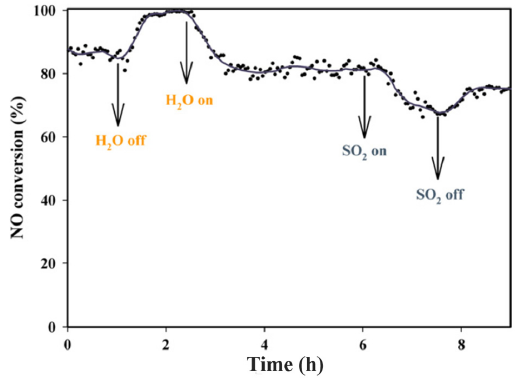
Figure 24. The effects of the H 2 O and SO 2 in the Mn/Ce(4)–TiO 2 catalysts with different ratio of Ce/Ti (Reaction condition: 200 ppm NO, 8% O 2 , 6% H 2 O, 100 ppm SO 2 , 0.28 g of sample and 500 cc/min total flow rate, tested at 180 ◦ C). (Reproduced with permission from Reference [45], Copyright 2012,